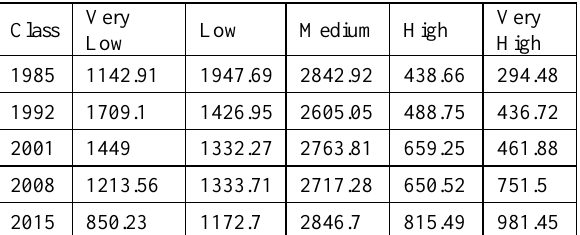
Figure 6. The surface temperature classification map After classification of normalized thermal data to temperature classes, the area of each class was calculated and its changes over the studied time period were assessed. The areas of different Temperature classes from 1985 to 2015 were presented in Table 5. Table 7. Area of the Temperature classes in